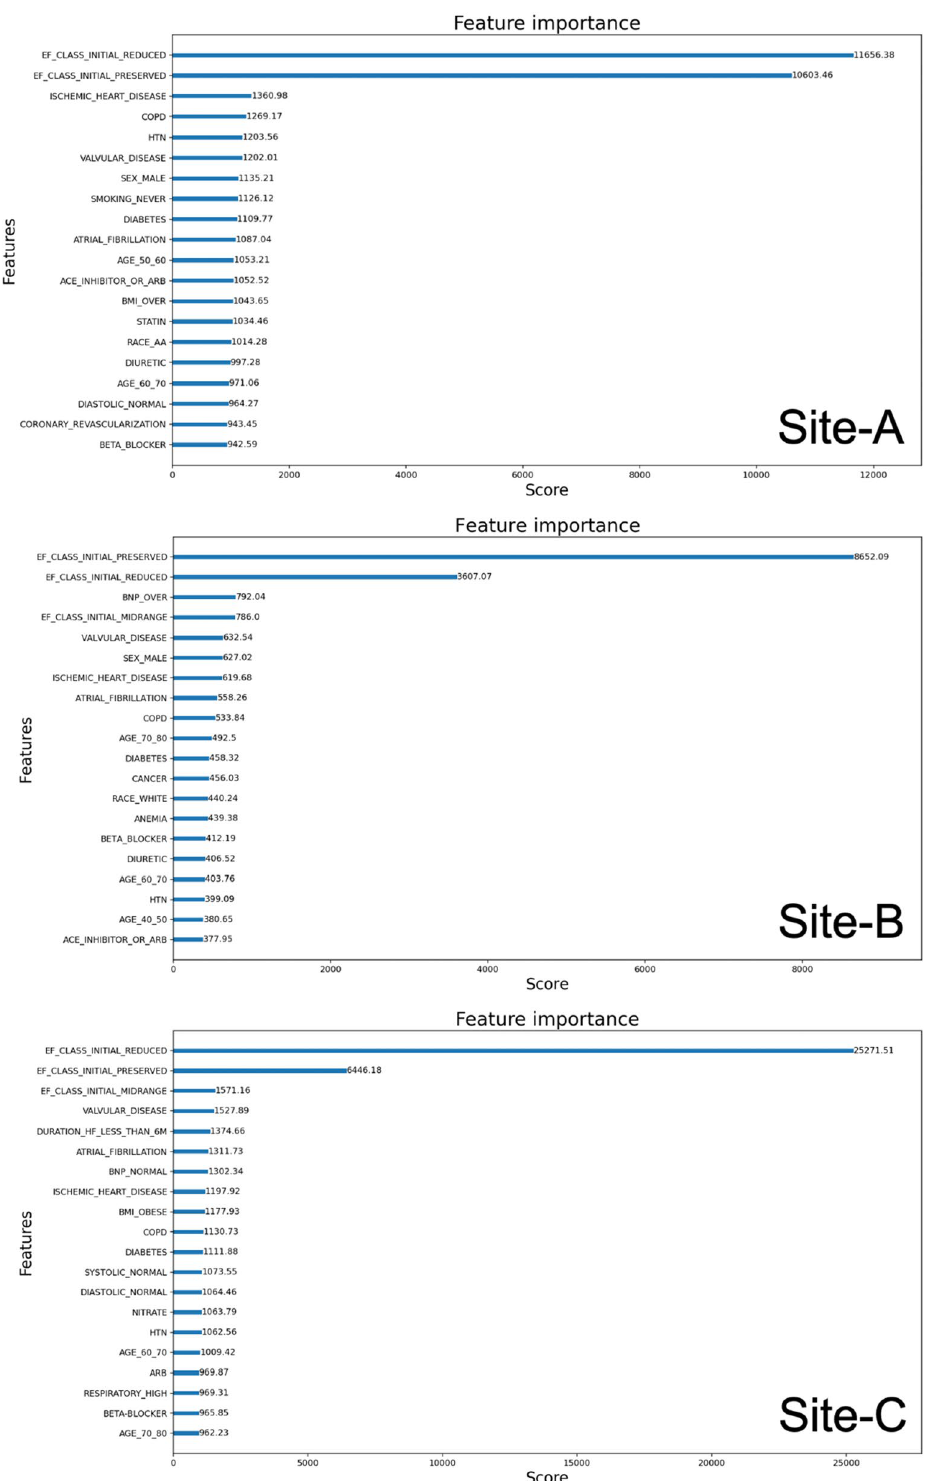
Figure 6. Top features in importance identified for a 30% EF increase at three